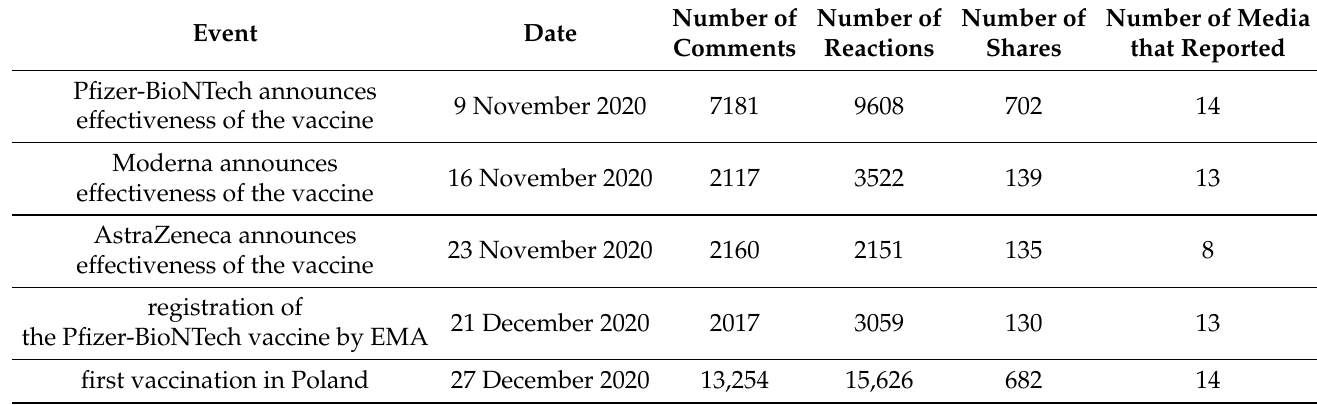
Table 2. Events included in the